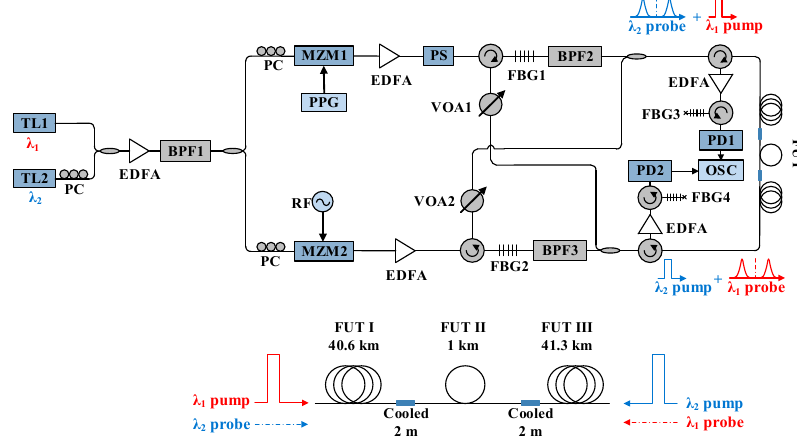
Figure 2. Experiment setup of BD-BOTDA system. TL: Tunable laser; PC: Polarization controller; EDFA: Erbium-doped fiber amplifier; BPF: Band pass filter; MZM: Mach–Zehnder modulator; PPG: Pulse pattern generator; PS: Polarization scrambler; VOA: Variable optical attenuator; FBG: